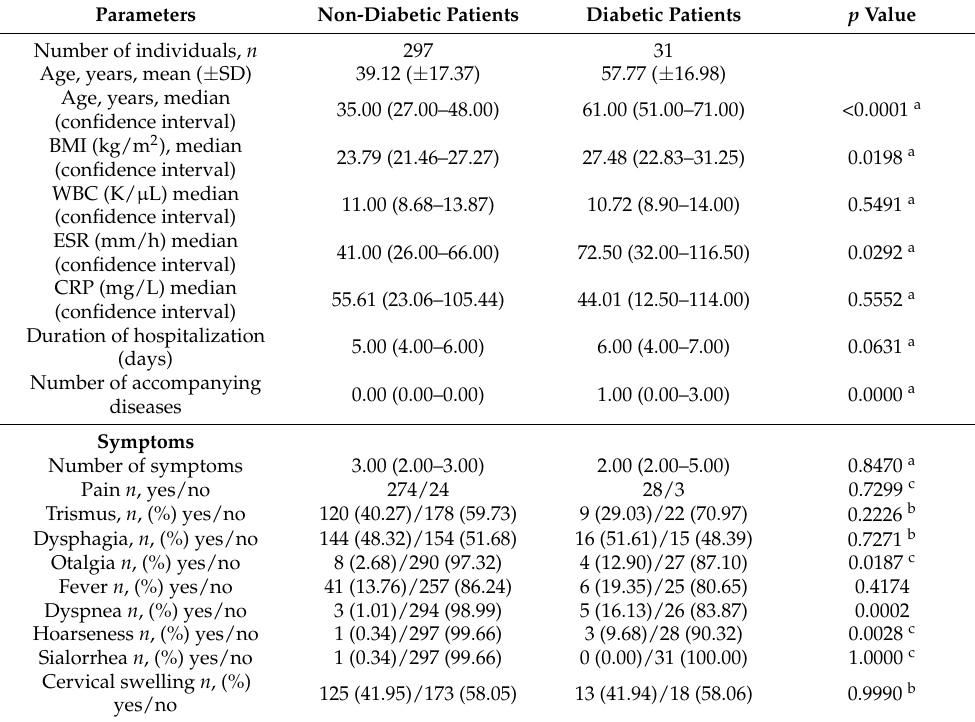
Table 3. Comparison of selected clinical and laboratory data between the diabetic and the non- diabetic